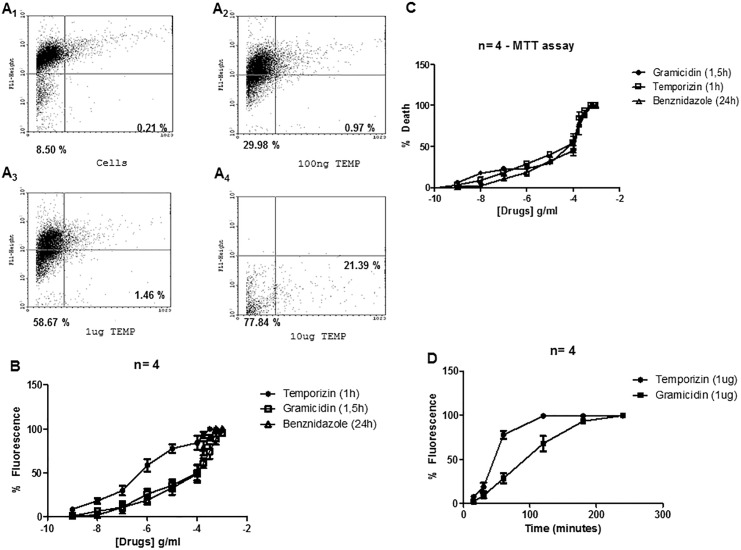
Temporizin kills Trypanosoma cruzi.A: T. cruzi were incubated, for the cell permeabilization assay, at 27°C for 45 minutes in the absence of treatments (A1) or presence of 100 ng/ml (A2), 1 μg/ml (A3) and 10 μg/ml temporizin (A4) for 60 minutes. B: Dose-response curves of temporizin, gramicidin and benznidazole acting against T. cruzi for 60, 90 and 1440 minutes, respectively. The trypanocide action was quantified for PI uptake using flow cytometry. C: MTT assays in the same conditions to B. D: Temporal quantification measuring PI entry after treatment with 1 μg/ml temporizin or gramicidin. These values represent the mean ± SD of three to five experiments performed on different days.